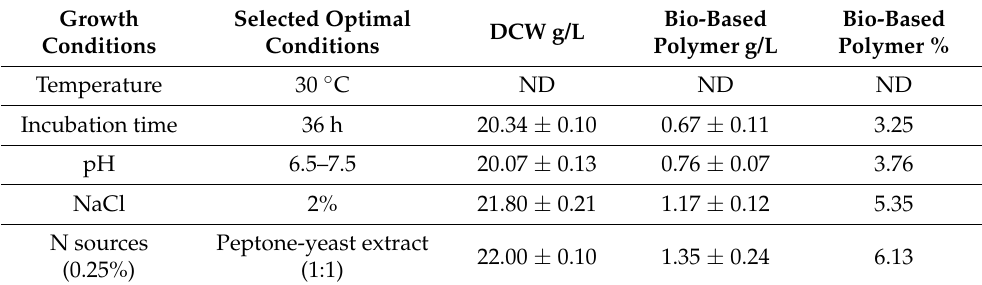
with selected optimal growth parameters.